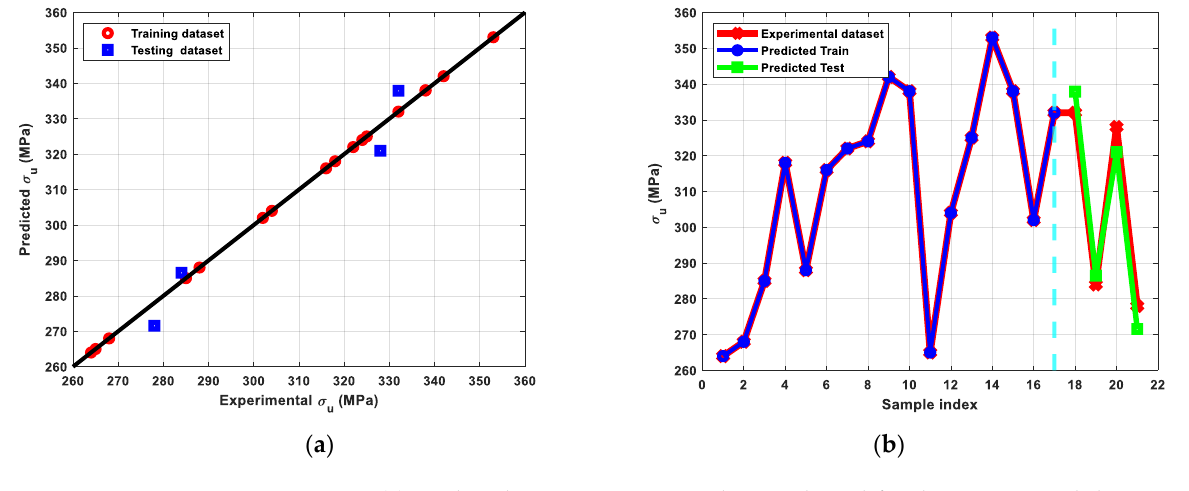
Figure 11. ( a ) Predicted versus experimental σ u evaluated for the training and the testing sets, ( b ) Predicted σ y versus sample index plotted for predicted train, predicted test, and experimental σ u data.